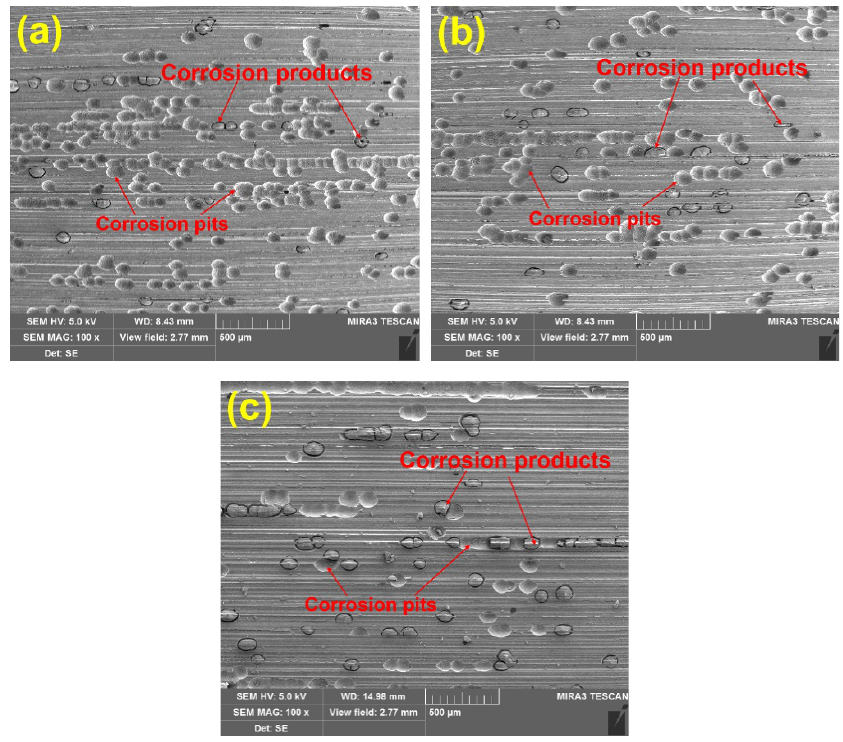
Figure 5. Scanning electron microscope (SEM) images of the corroded surface of samples prepared using under different particle sizes: ( a ) 36 M, ( b ) 80 M, ( c ) 120 M.